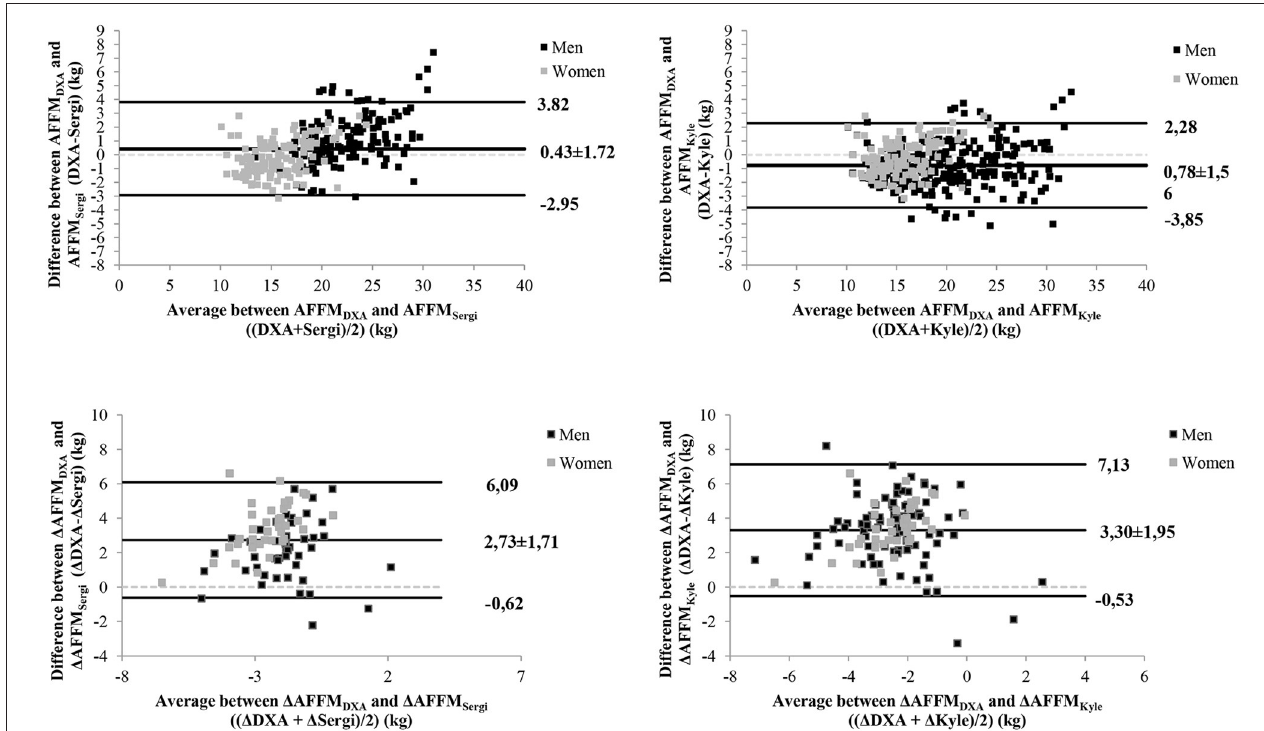
FIGURE 1 | Bland-Altman plots for AFFM Sergi and AFFM Kyle predictive equations compared with DXA results, in total sample, for cross-sectional and body composition changes data ( 1 ).